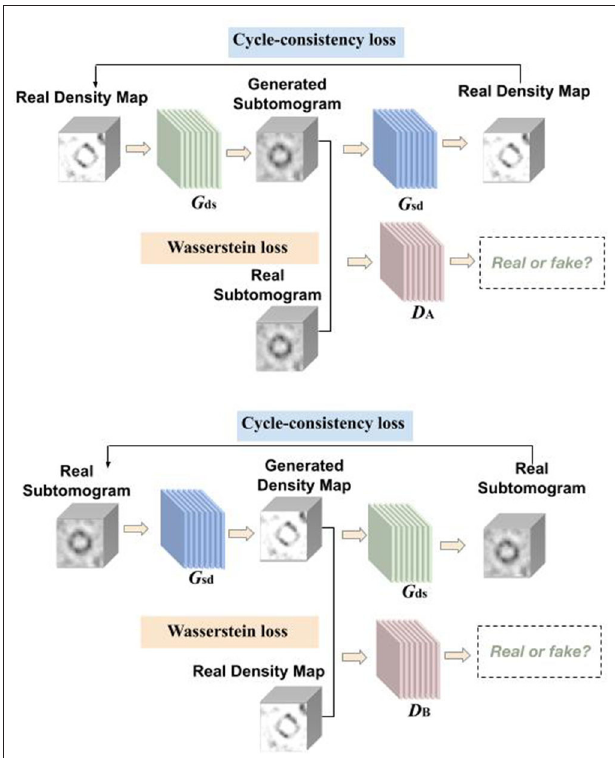
FIGURE 1 | Overview of CryoETGAN: with adversarial loss, cycle-consistency loss, and Wasserstein loss, our method is capable of learning mapping between domain S and D with unpaired